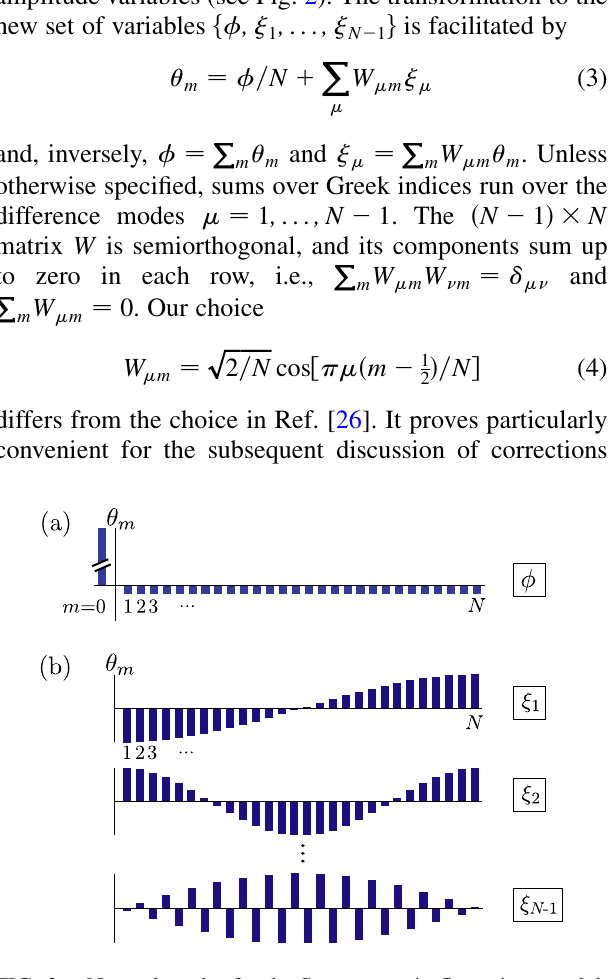
FIG. 2. Normal modes for the S N symmetric-fluxonium model. The plots show the array-variable amplitudes (cid:1) m for each normal mode. (a) Superinductance mode ½ (cid:4) (cid:4) , for which all array- junction amplitudes (cid:1) m are identical. (b) Difference